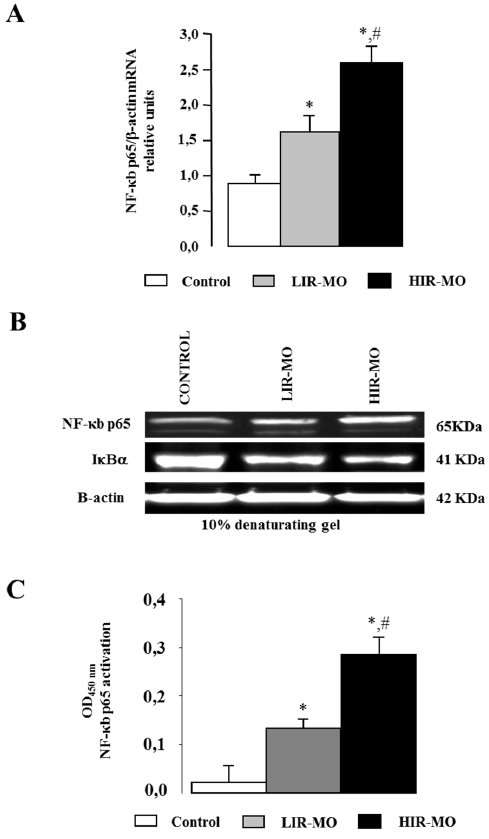
Figure 5. NF- κ B activation in non-obese, LIR-MO, and HIR-MO. Quantitative RT-PCR for NF- κ B ( A ) mRNA was performed on human VAT. Specific mRNAs were normalized to b-actin levels. The panels show the mean ± SEM from 8 subjects per group. Significant differences (Duncan, p < 0.05) are indicated with different letters. Total protein extracts were immunoblotted with antibodies targeting NF- κ B p 65, I κ B α , and b-actin ( B ) and for detecting binding affinity of NF- κ B p 65 ( C ) families to the response element consensus oligonucleotide on 96-well plates (Trans-AM kits). Means (± SEM, n = 8). Significance of differences * p < 0.05, between control vd MO groups, and # p < 0.01 between LIR-MO and